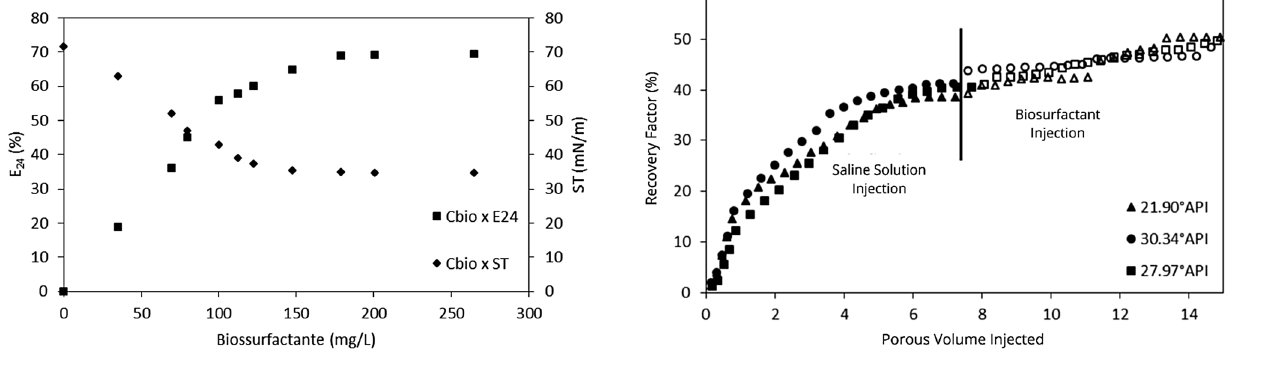
Fig. 5 Recovery factor as a function of porous volume injected for biosurfactant solution 100% above